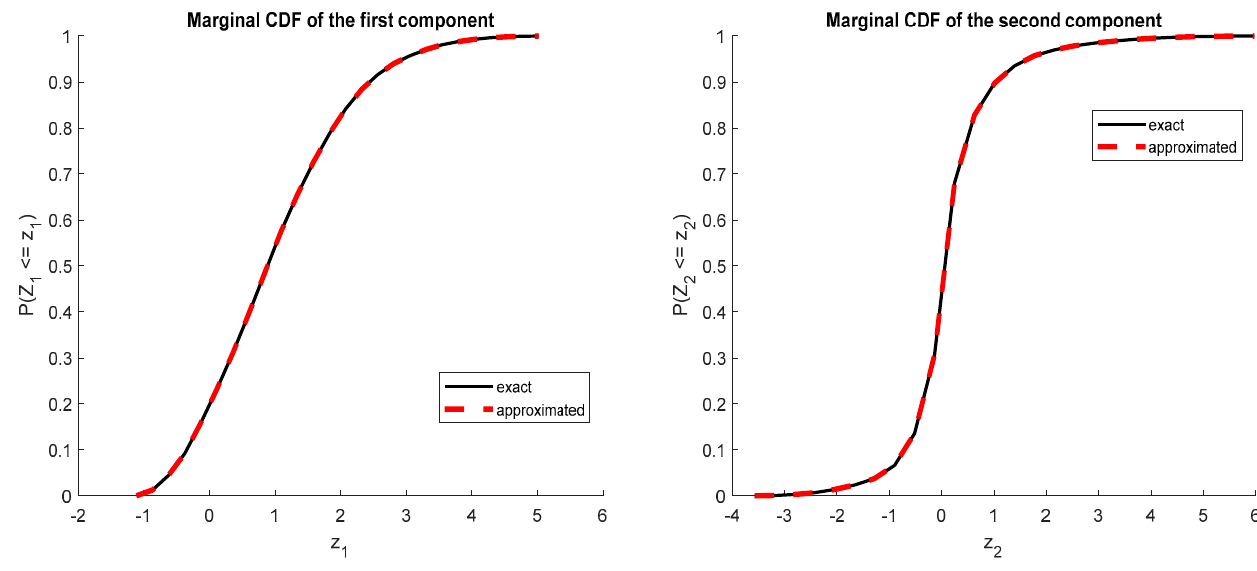
Figure 2. Cumulative density function obtained by collocation in the first